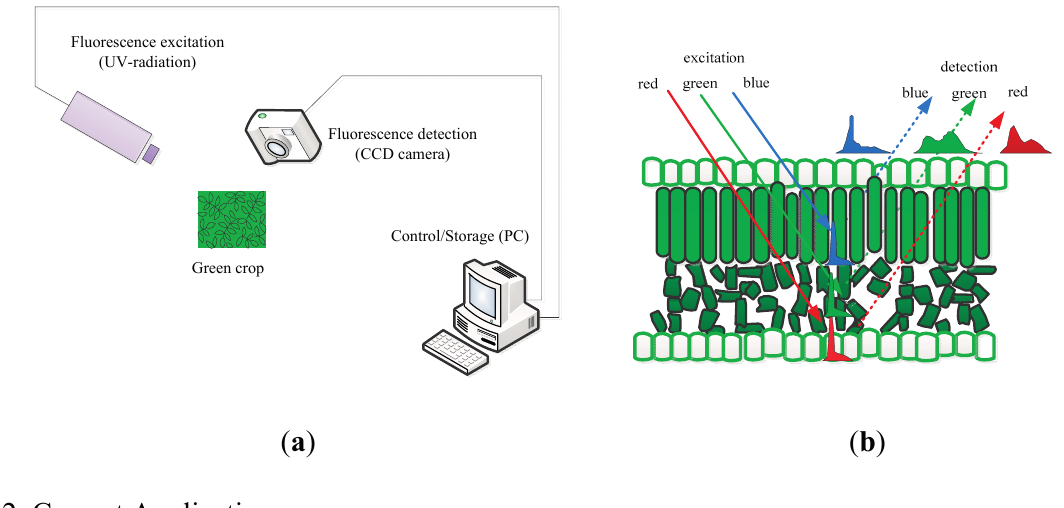
Figure 3. A scheme for the multi-color fluorescence imaging system ( a ) and the chlorophyll fluorescence emission of green leaves as induced blue, red and green excitation light ( b )